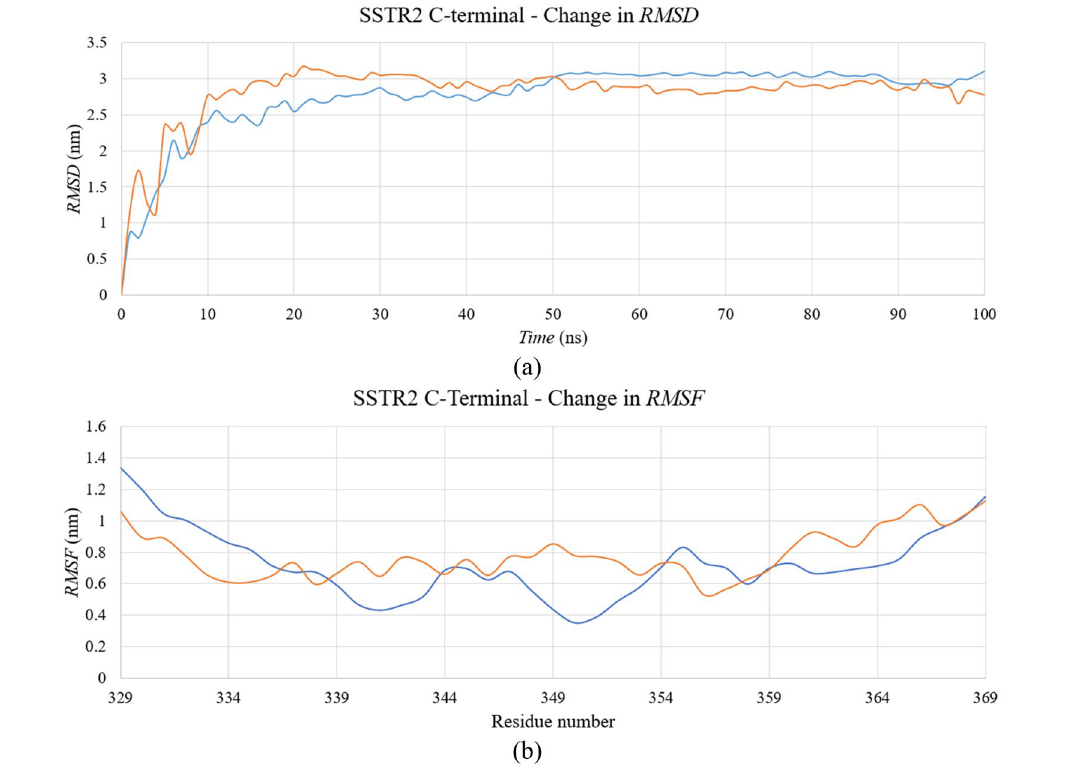
Figure 10. Time evolution of ( a ) RMSD and ( b ) RMSF of SSTR2 C-terminal domain. Systems with presence and absence of DPPC bilayer are represented as blue and orange lines, respectively. Figure generated using PyMOL 1.3 (http:// www. pymol.